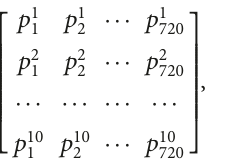
5, τ 2, and α Z (cid:31) (cid:31)